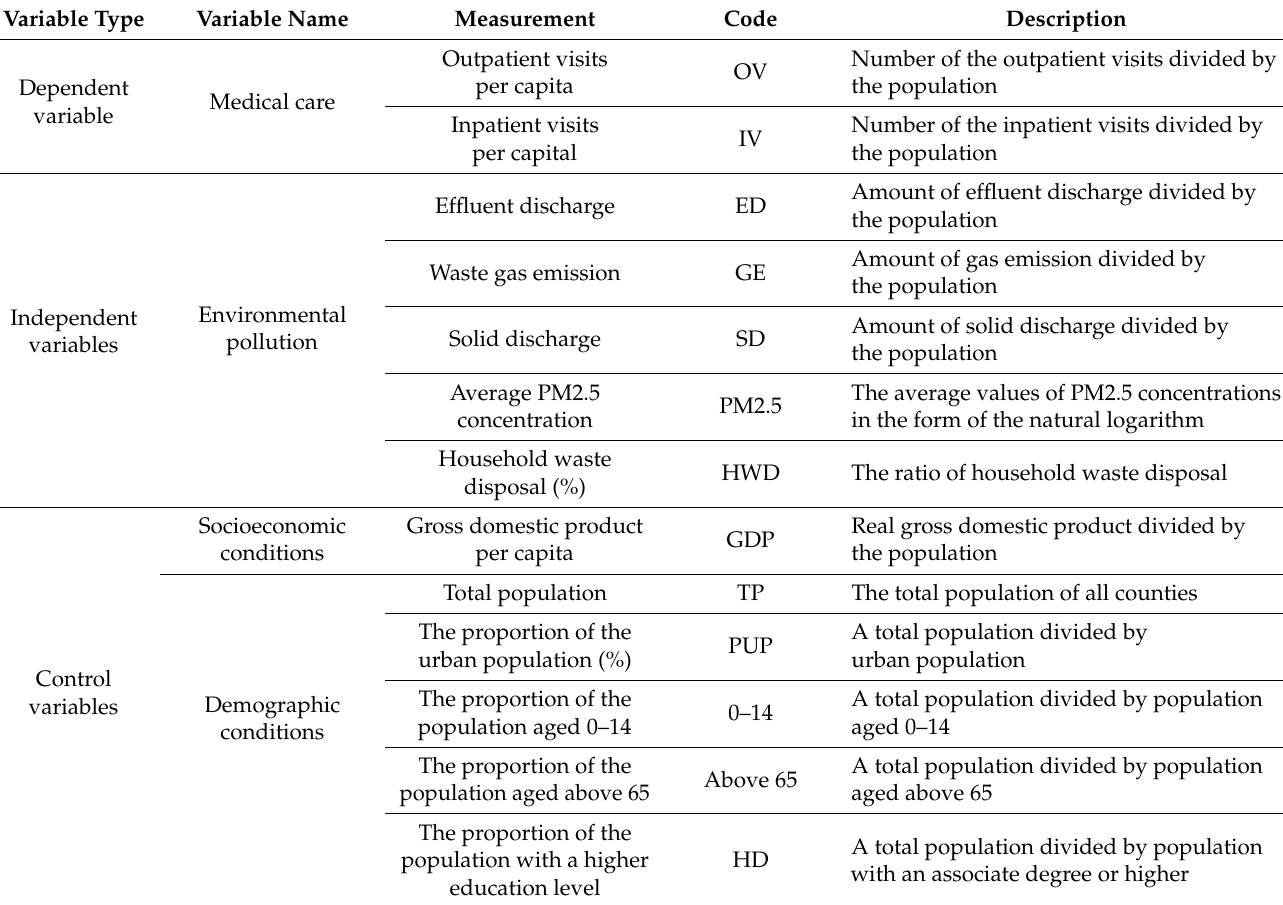
Table 2. Variables and data